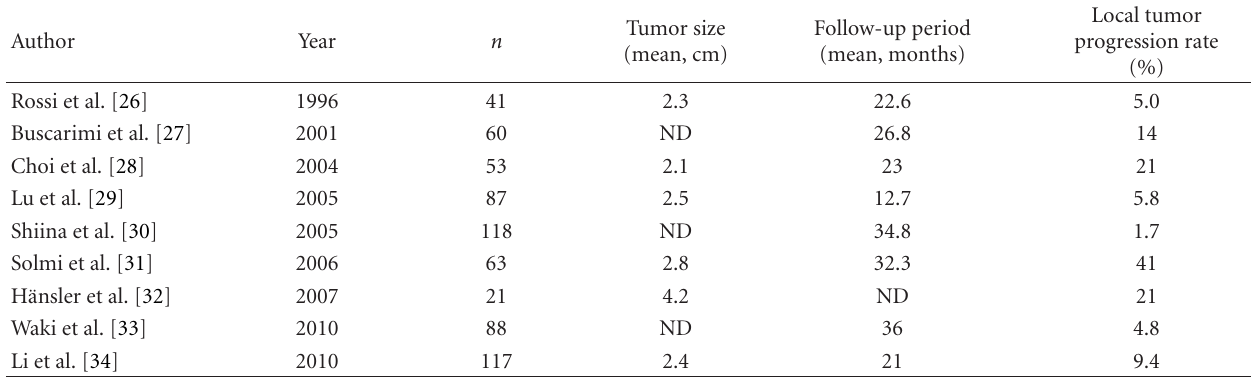
Table 2: Local tumor progression rates after RFA for